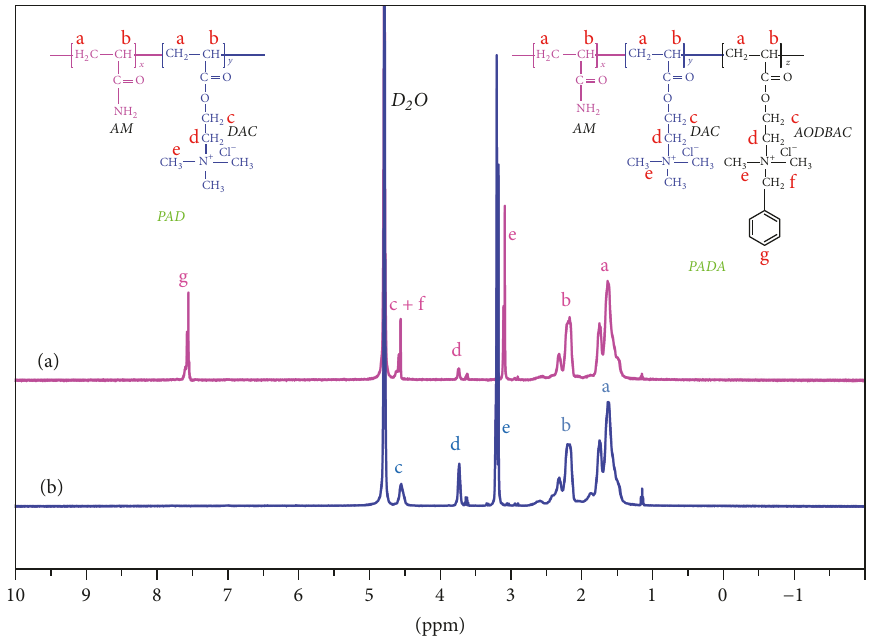
Figure 4: 1 H NMR spectrum of (a) PADA and (b)